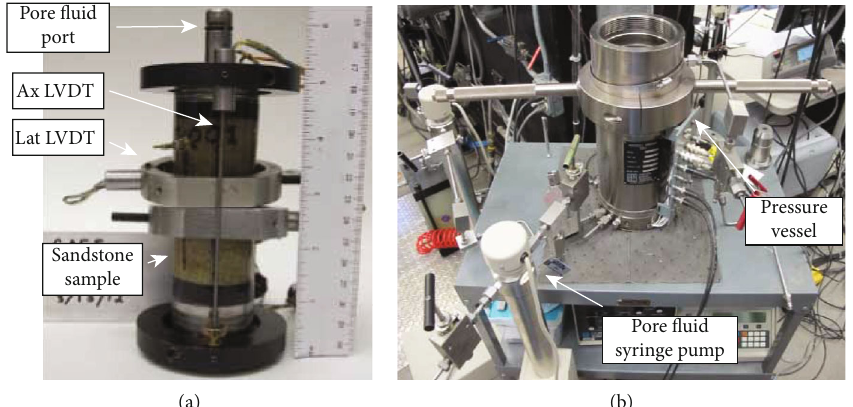
Figure 2: Setup for hydrostatic tests: (a) sample con fi guration for samples during hydrostatic tests; (b) pressure vessel and pumps utilized for conducting each experiment.